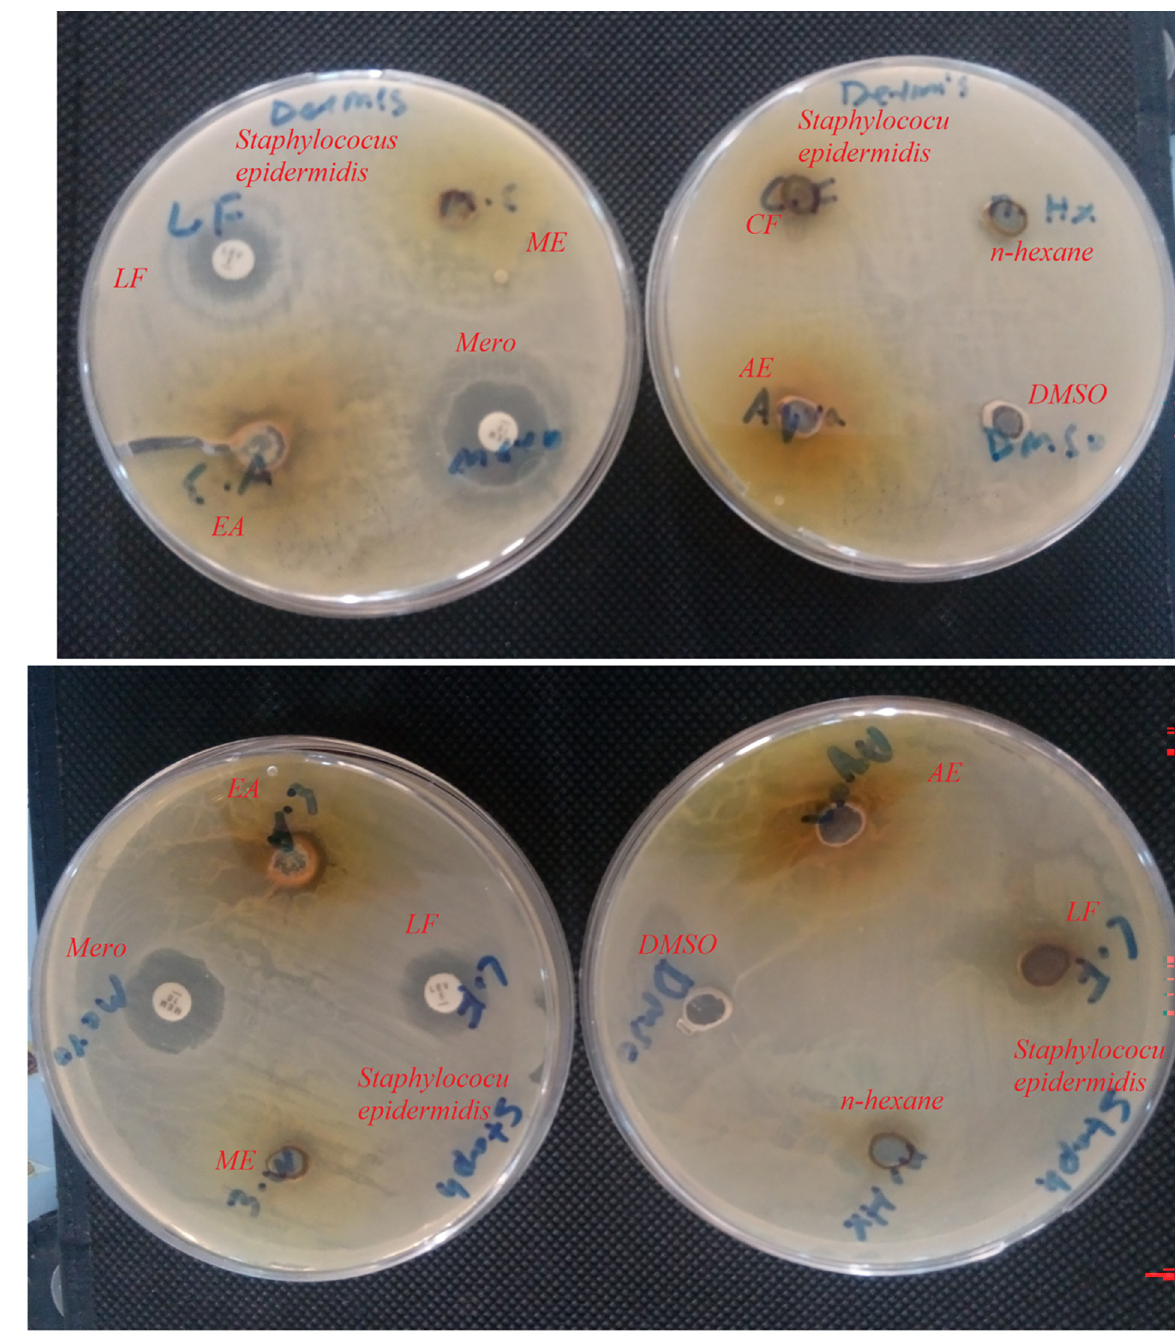
Fig 2. Inhibition of bacterial growth by extract. Aqua: Aqueous Sub-fraction: C.F: Chloroform Sub-fraction; DMSO: Dimethyl Sulfoxide Sub- fraction; E.A: Ethyl Acetate Sub-fraction; L.F: Levofloxacin; M.E: Methanolic Extract; MERO: